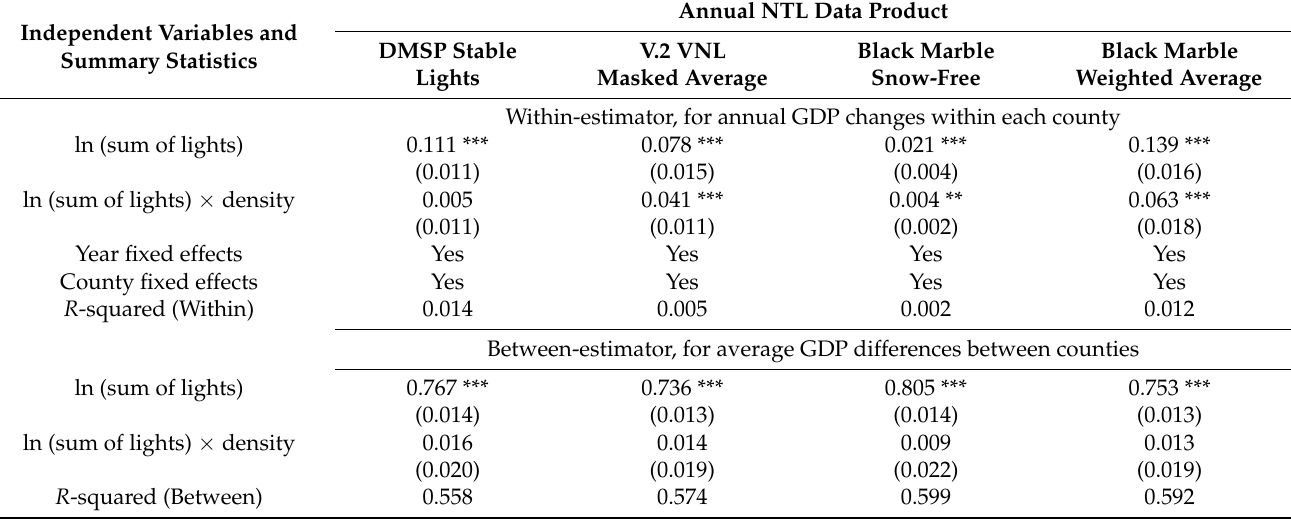
Table 5. Effects of population density on the relationship between NTL variables and county-level